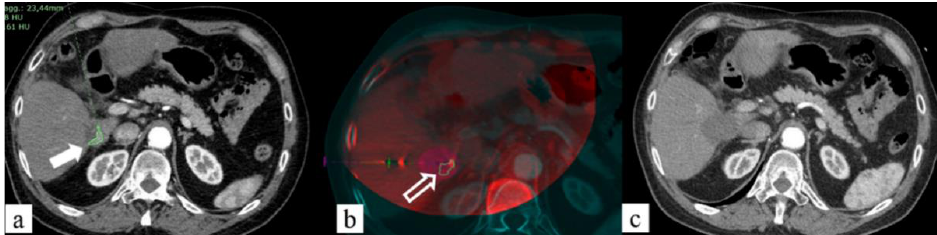
Figure 4. Sixty-seven-year-old male, residual tumor (arrows) close to inferior vena cava margin after US-guided RFA of HCC: MWA ablation. ( a ) Contrast-enhanced CT (CECT) axial image with segmentation of residual tumor to treat (fill white arrow); ( b ) fused images obtained using CECT and CBCT after US-guided MWA probe positioning into residual tumor (empty white arrow) with predicted ablation area overlaying and the segmented tumor visualized on CT image; ( c ) 1-month follow-up CECT demonstrated complete ablation of residual tumor treated (no residual hypervascular area).